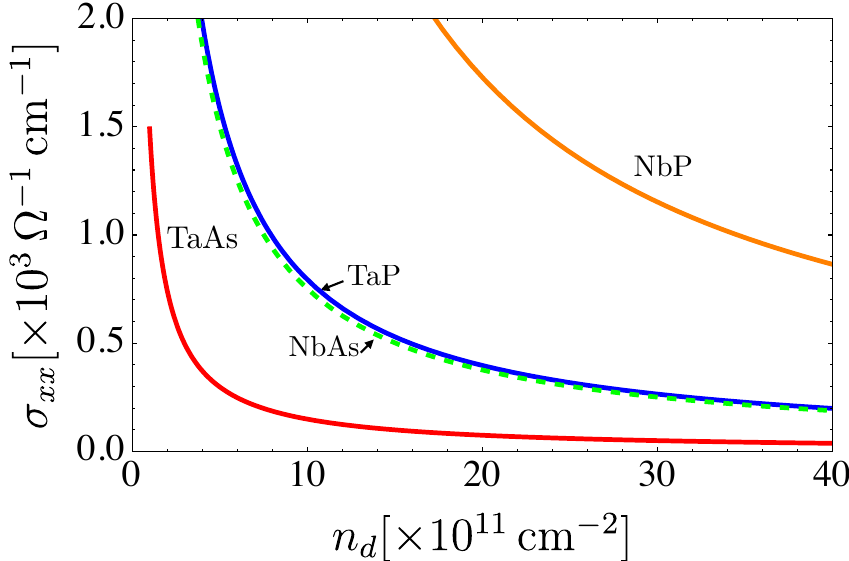
Figure 10. Plot of total conductivity versus defects’ concentration. The graphs were computed at zero